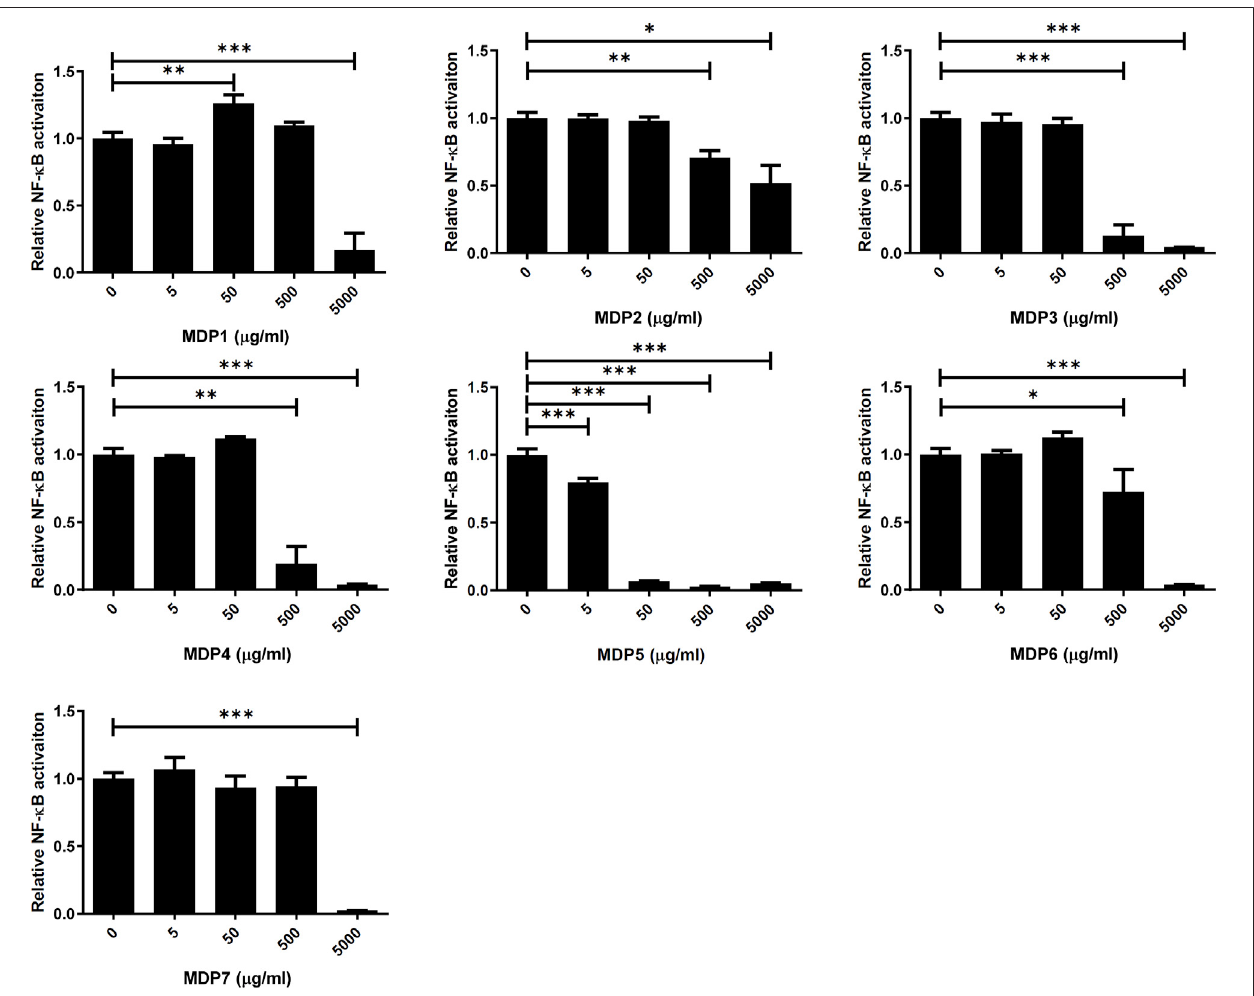
FIGURE 2 | Screening of inhibitory effects of MDP fractions on the NF-kB reporter. THP-1 cells were treated with different concentrations of individual MDP fractions (0, 5, 50, 500, or 5,000 ug/ml) and stimulated with the TLR2 ligand, Pam3CSK4. After stimulation for 24 h, promoter activities were measured. Data are the mean ± S.D. ( n (cid:1) 3 – 5). ** p < 0.01, *** p < 0.001. Data were analyzed using the Student ’ s t -test